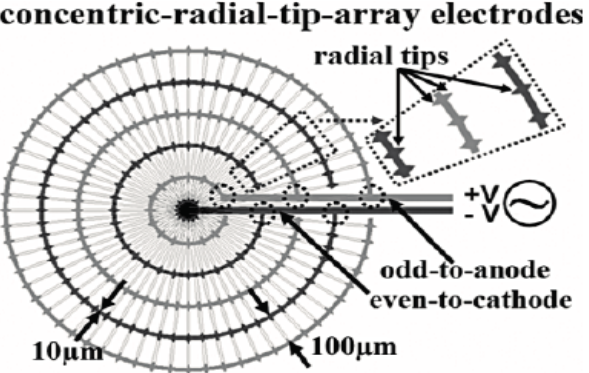
Figure 4. Concentric-stellate-tip microelectrode for 2D liver cell patterning. Reproduced with permission